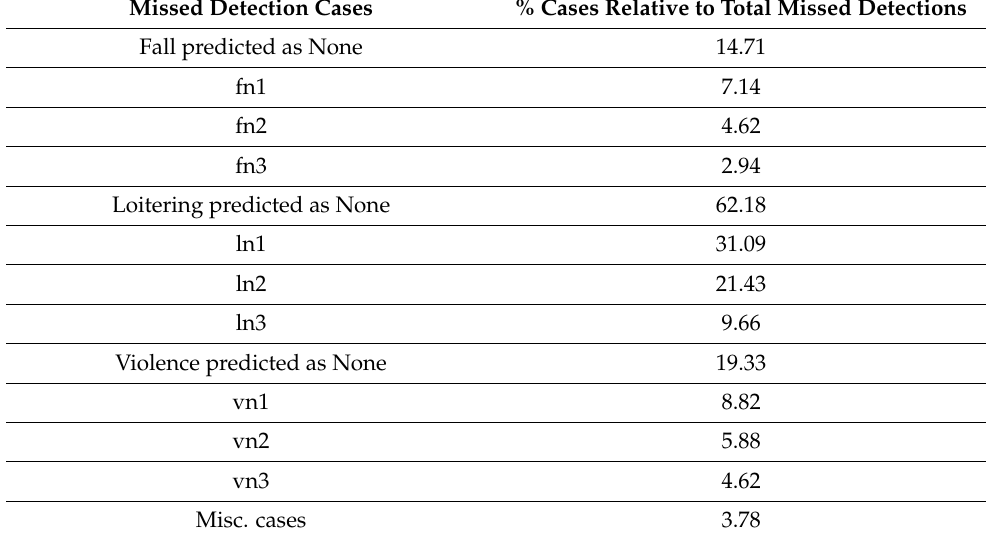
Table 3. Percentage of different cases of missed detections. Missed Detection